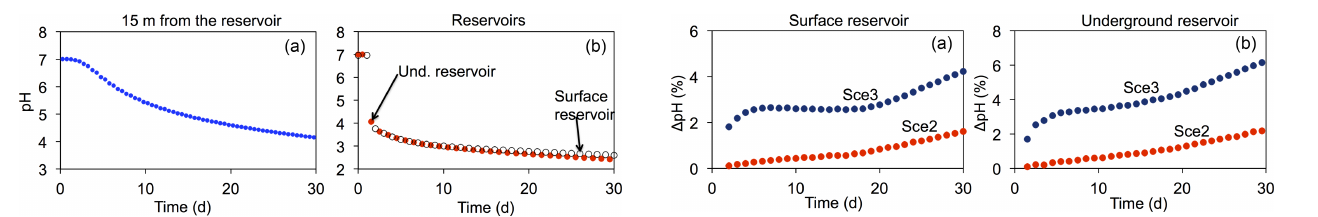
Figure 2. pH evolution in the surrounding porous medium at 15m from the underground reservoir (a) . pH evolution in the reservoirs (b) . These results are obtained for Sce1.